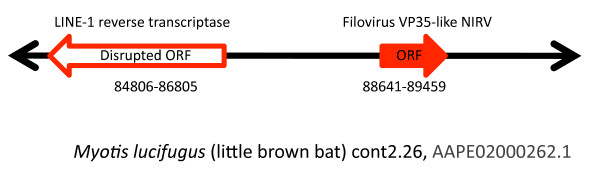
Map showing the position of the filovirus VP35-like gene and the nearby LINE-1 reverse transcriptase gene in bats of the genus Myotis. The solid arrows represent an open reading frame (ORF), and the hollow arrow represents a disrupted ORF. Numbers below the arrow show the boundaries of the annotation in the contig.